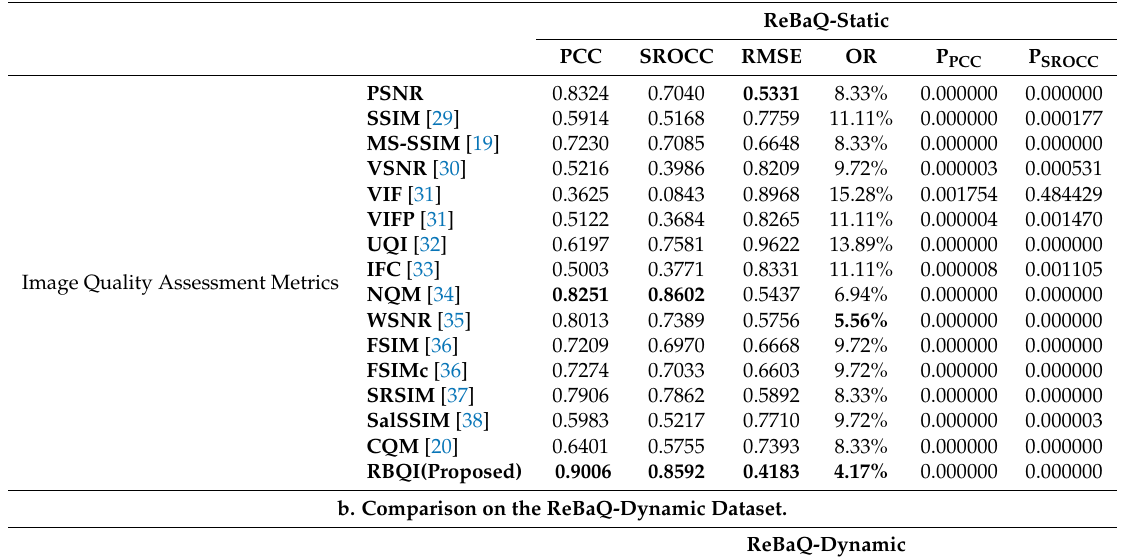
a. Comparison on the ReBaQ-Static Dataset.